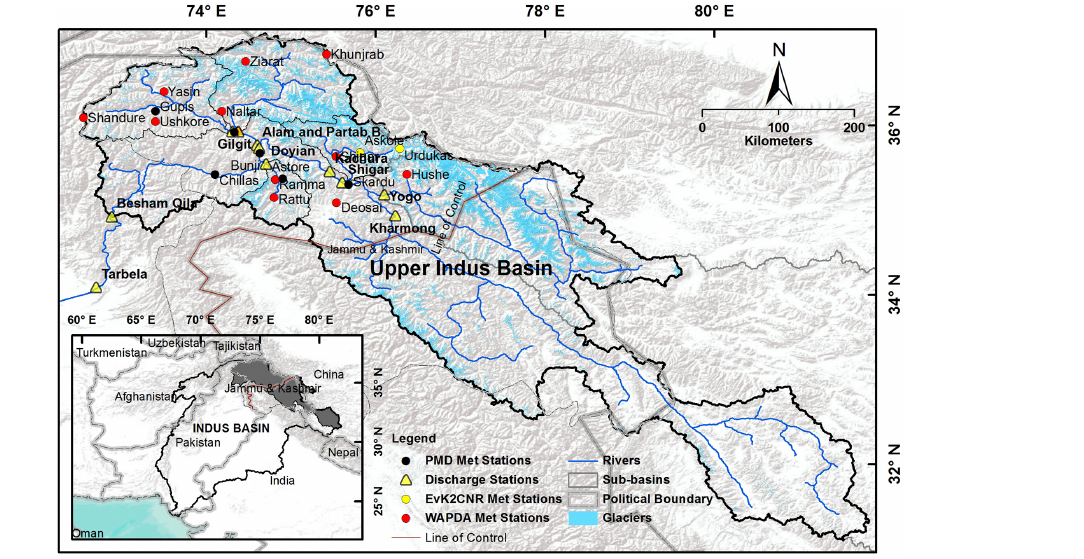
Figure 1. The upper Indus Basin (UIB) and meteorological station